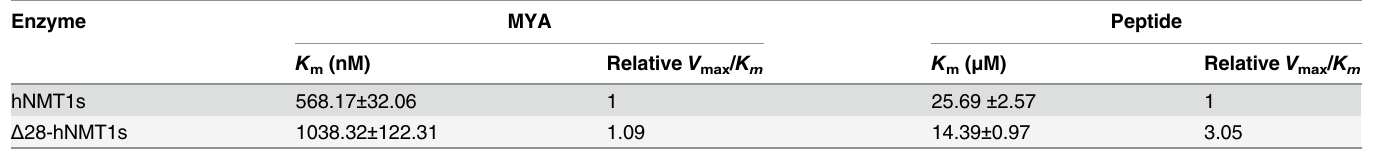
strates become available very quickly and require to be N-myristoylated to perform their Table 3. Kinetic analysis of the myristoylation reaction by full-length catalytic domain (hNMT1s) and N-terminal truncated ( Δ 28-hNMT1s) human N -myristoyltransferase 1.